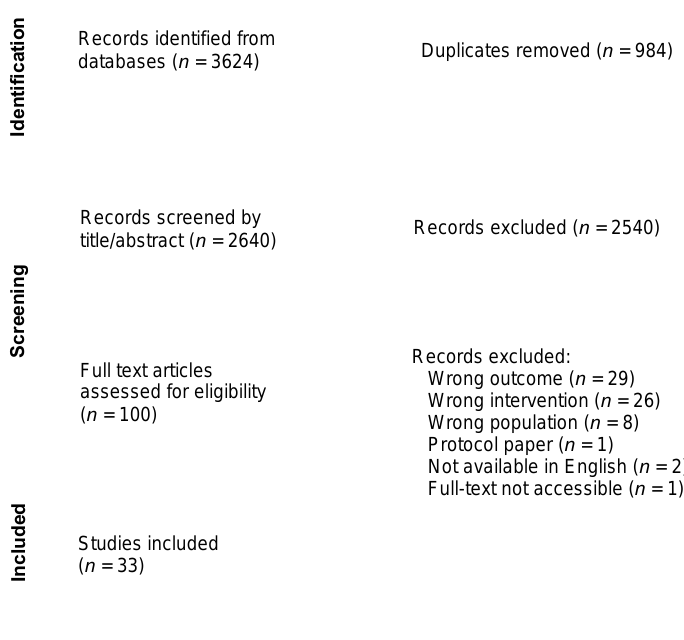
Figure 1. PRISMA 2020 flow diagram for the rapid review process.